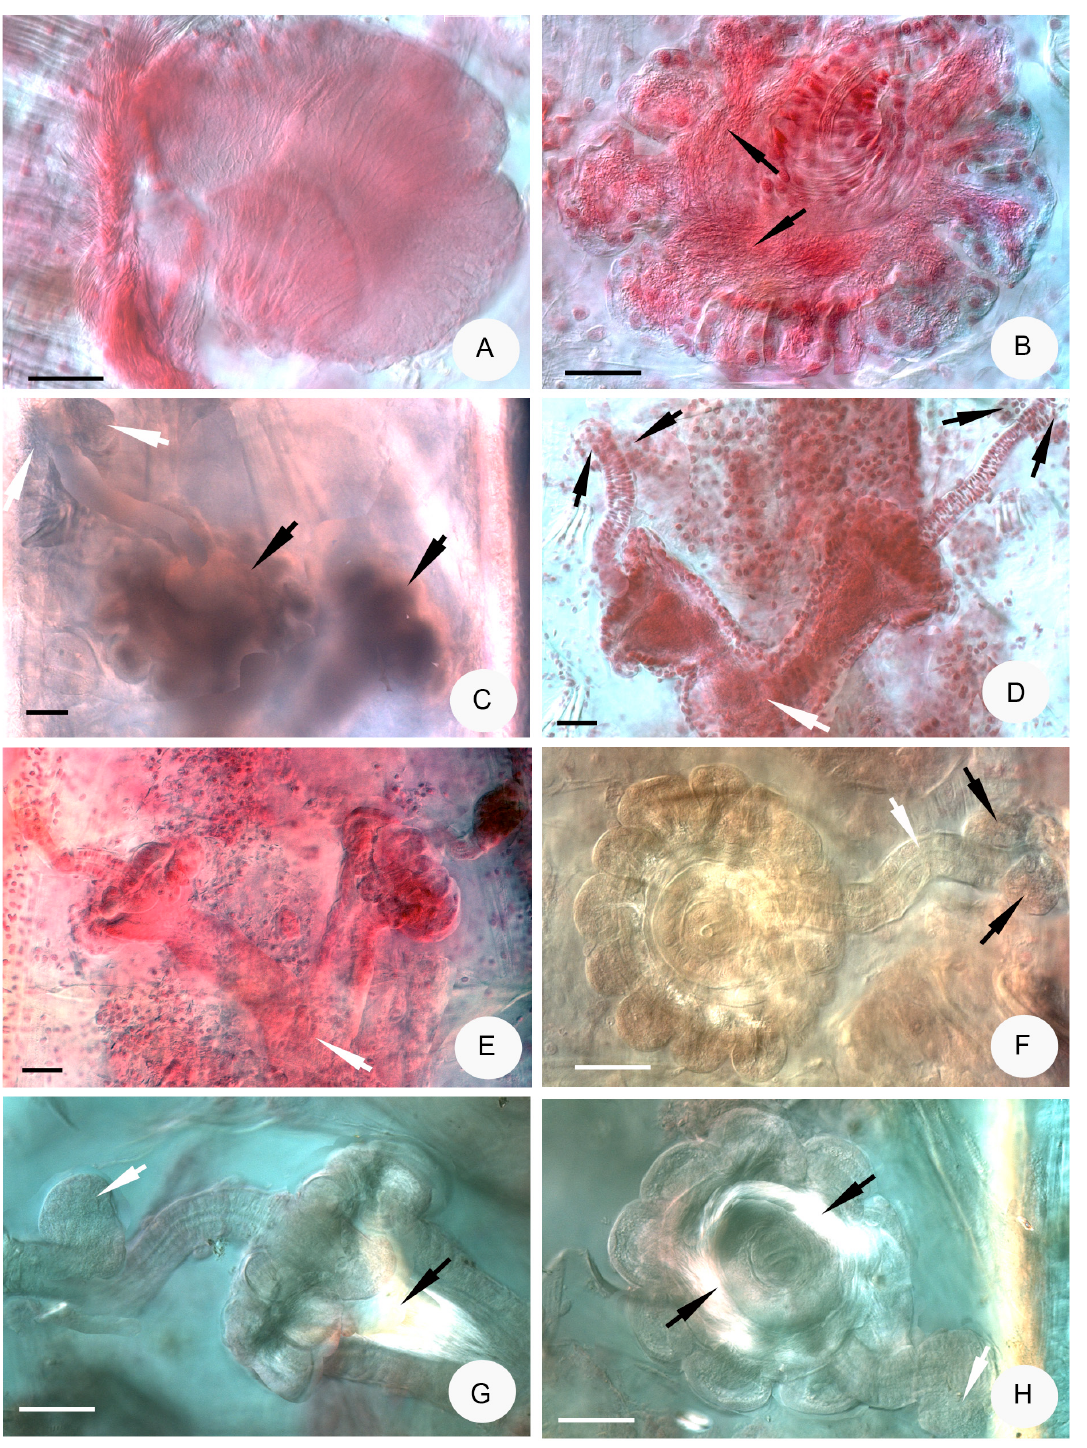
Fig. 5. Micrograph of Fridericia spelaeophila sp. nov. A . Sperm funnel. B , H . Spermathecal ampullae (sperm in ampulla marked with arrows). C – G . Spermathecae. (In C, diverticula marked with black arrows, ectal glands with white arrow. D–E. Fused proximal parts marked with white arrows, ectal glands with black arrows. F. Ectal duct marked with white arrow, ectal glands with black arrows. G. Ectal glands marked with white arrow, the refractive sperm in ampullar distal part marked with black arrow). All pictures fixed and stained. E from holotype. Scale bars: 50